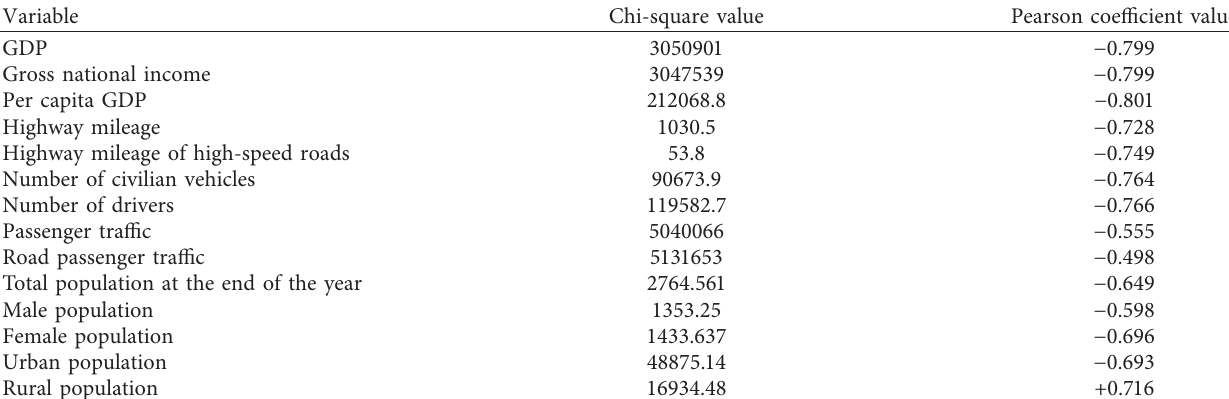
Table 2: Chi-square value and Pearson coefficient value.